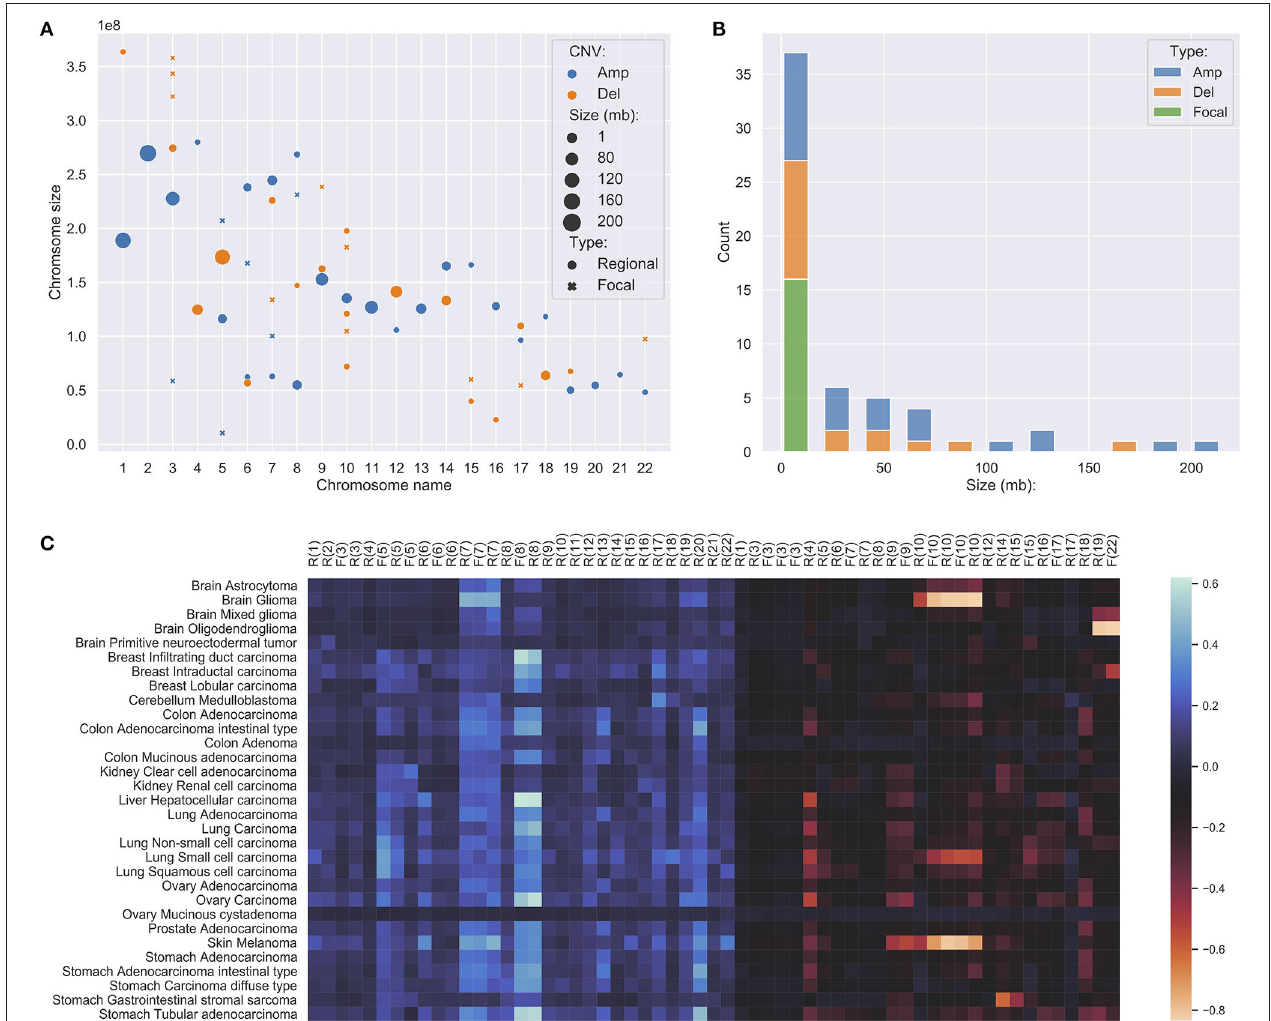
FIGURE 3 | (A) The distribution of focal and regional feature groups on the genome. The groups were generated from the 927 feature genes, where genes within 5 million-bases were merged into a group. The position of the mark was determined using the center of the group or gene. The size of the mark was determined by the length of the group or gene, in the unit of million-bases and a minimum size of 1 MB. (B) The length distribution of feature groups. (C) The amplitude of feature groups in 31 studied cancer subtypes. The values were computed using the average of the normalized CNV log ratios of all samples in each subtype. On the x-axis, F denotes focal, R denotes regional, the number denotes chromosome